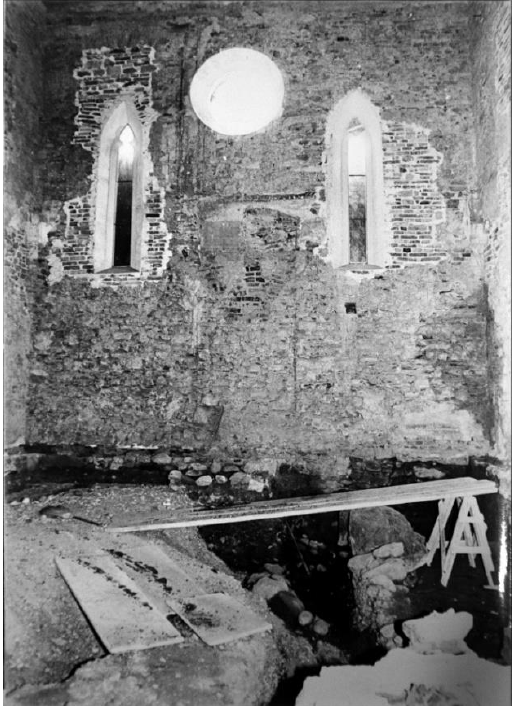
Figure 10. Eastern wall of the synagogue during excavations. Interior. Photo: The Maribor Regional Office of the IPCHS, Fond Maribor—Sinagoga.